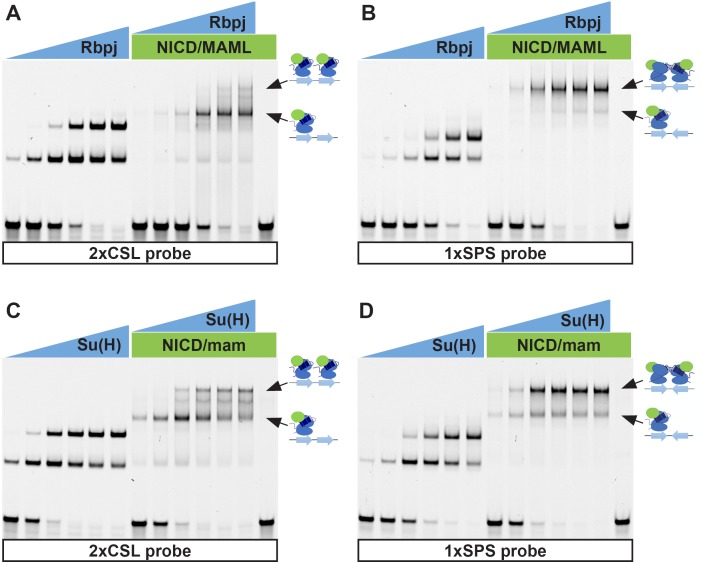
Individual channels of EMSAs.(A–D) EMSAs using purified mammalian NCM proteins (A–B) or fly NCM proteins (C–D) and labeled 2xCSL (A, C) and 1xSPS (B, D) probes. Arrows highlight bands consistent with one vs two NCM complexes on DNA. The data shown in this figure are the isolated grayscale images of those shown in color in Figure 1B–C. Note, the fly and mouse proteins both cooperatively bind the 1xSPS but not the 2xCSL probe. However, we did observe that using the same concentration of mouse proteins resulted in the formation of more 2NCM complex on the 1xSPS probe relative to the fly proteins, suggesting that the mouse proteins may be more cooperative than the fly proteins. However, since we are not using full-length NICD and MAM proteins from either species due to difficulty in purifying these large proteins, additional studies are required to confirm the relevance of this observed difference.